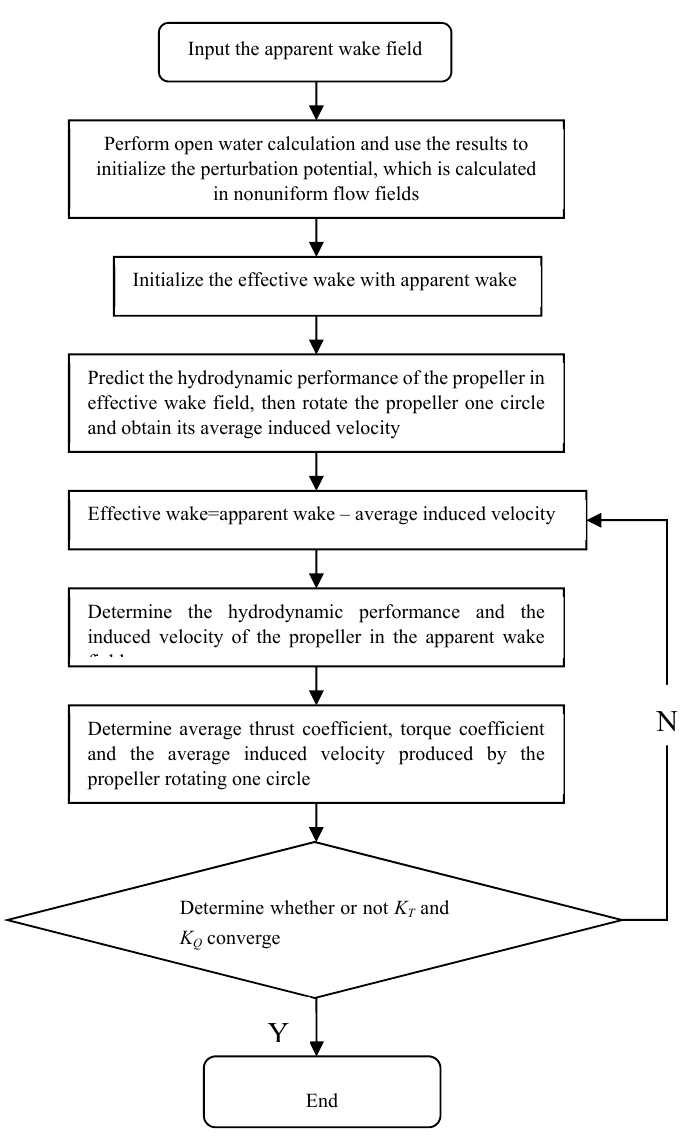
Figure 2. Flowchart of the effective wake field calculation.